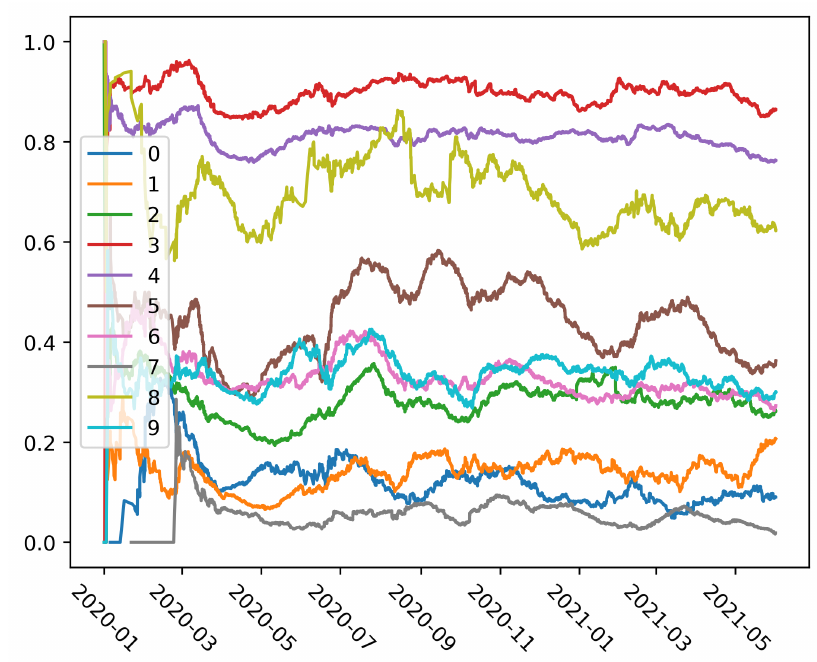
Figure 6. Sentiment (negativity) by clusters through time with a sliding window of 30 days. Positive direction on the y-axis represents negative